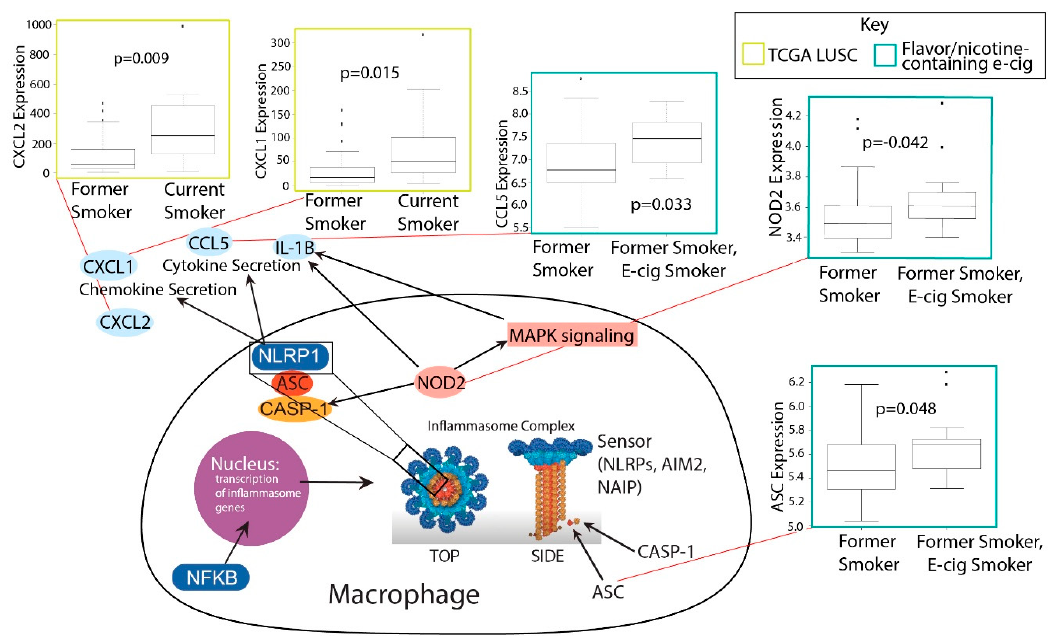
Figure 3. Boxplots of significant correlations of e-cig or tobacco use with upregulation of inflammasome genes (Kruskal–Wallis, p < 0.05). A schematic linking the genes upregulated with their function within inflammasome pathways is shown.